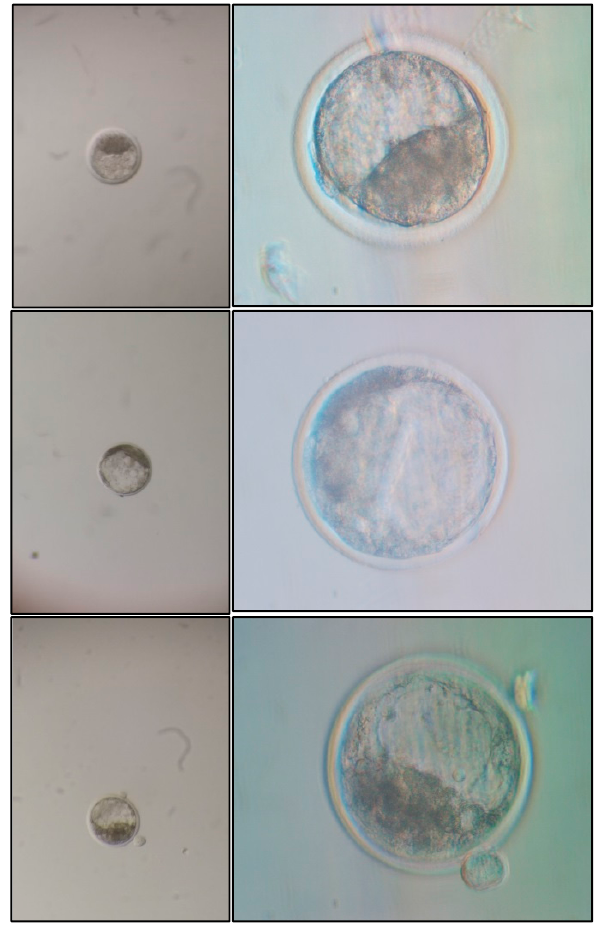
Figure 1. Illustrative images captured by the smartphone without a macro lens ( left column) and with an inverted microscope ( right column), from three different embryos ( upper , middle , and bottom lines). 2.1. Smartphone Image Resizing